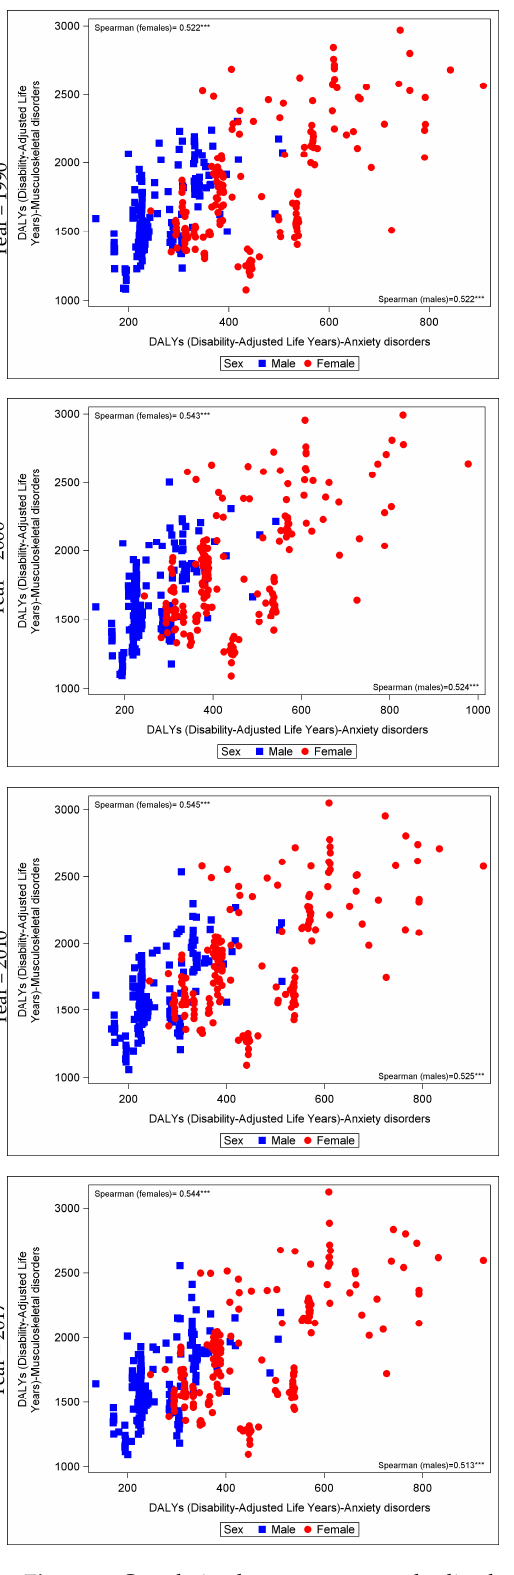
Figure 3. Correlation between age-standardized musculoskeletal and anxiety disorders DALYs among 195 countries, analyzed by gender, between 1990 and 2017. *** p < 0.0001.